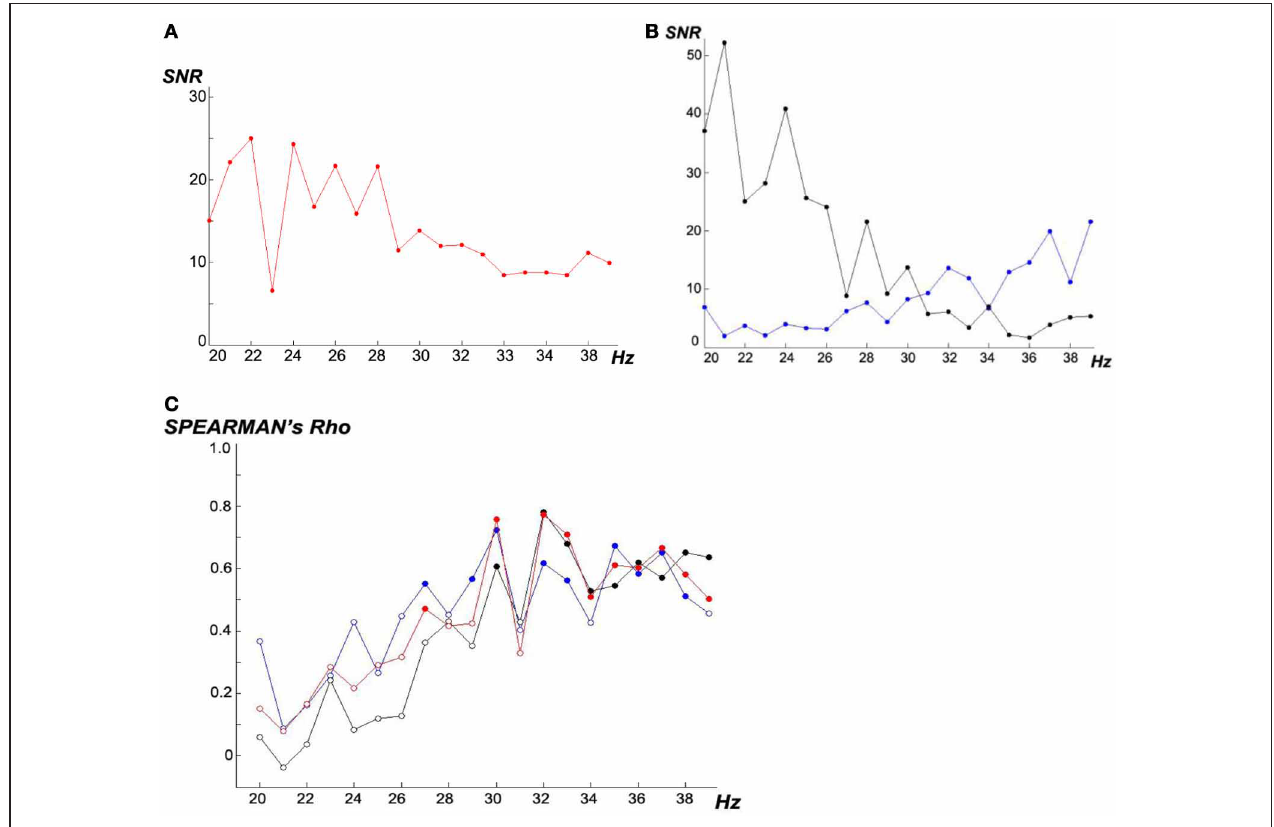
magnitudes and ITR performances under the three experimental conditions, computed as Spearman ’ s rank order correlations: (i) ACL algorithm (red), (ii) top (blue) and (iii) prefixed (black), filled circles represent significant p < 0 .